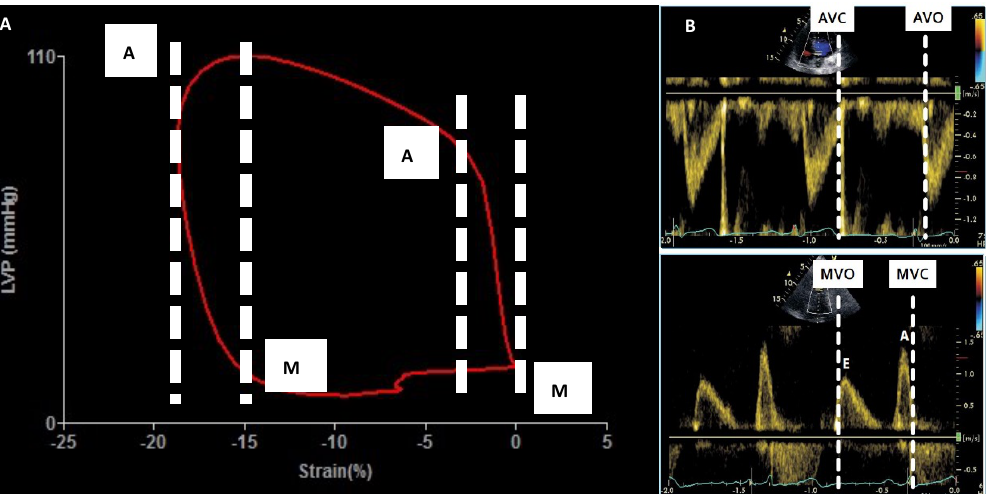
Figure 1. Methodology for measuring strain-derived myocardial work. In the left side the strain pressure loop: the area inside the loop corresponds to global work index (panel A ). In the right panel Doppler-derived measurement needed to mark systolic and diastolic time intervals (panel B ). AVC = Aortic valve closure, AVO = Aortic valve opening, LVP = Left ventricular pressure, MVC = Mitral valve closure, MVO = Mitral valve opening.